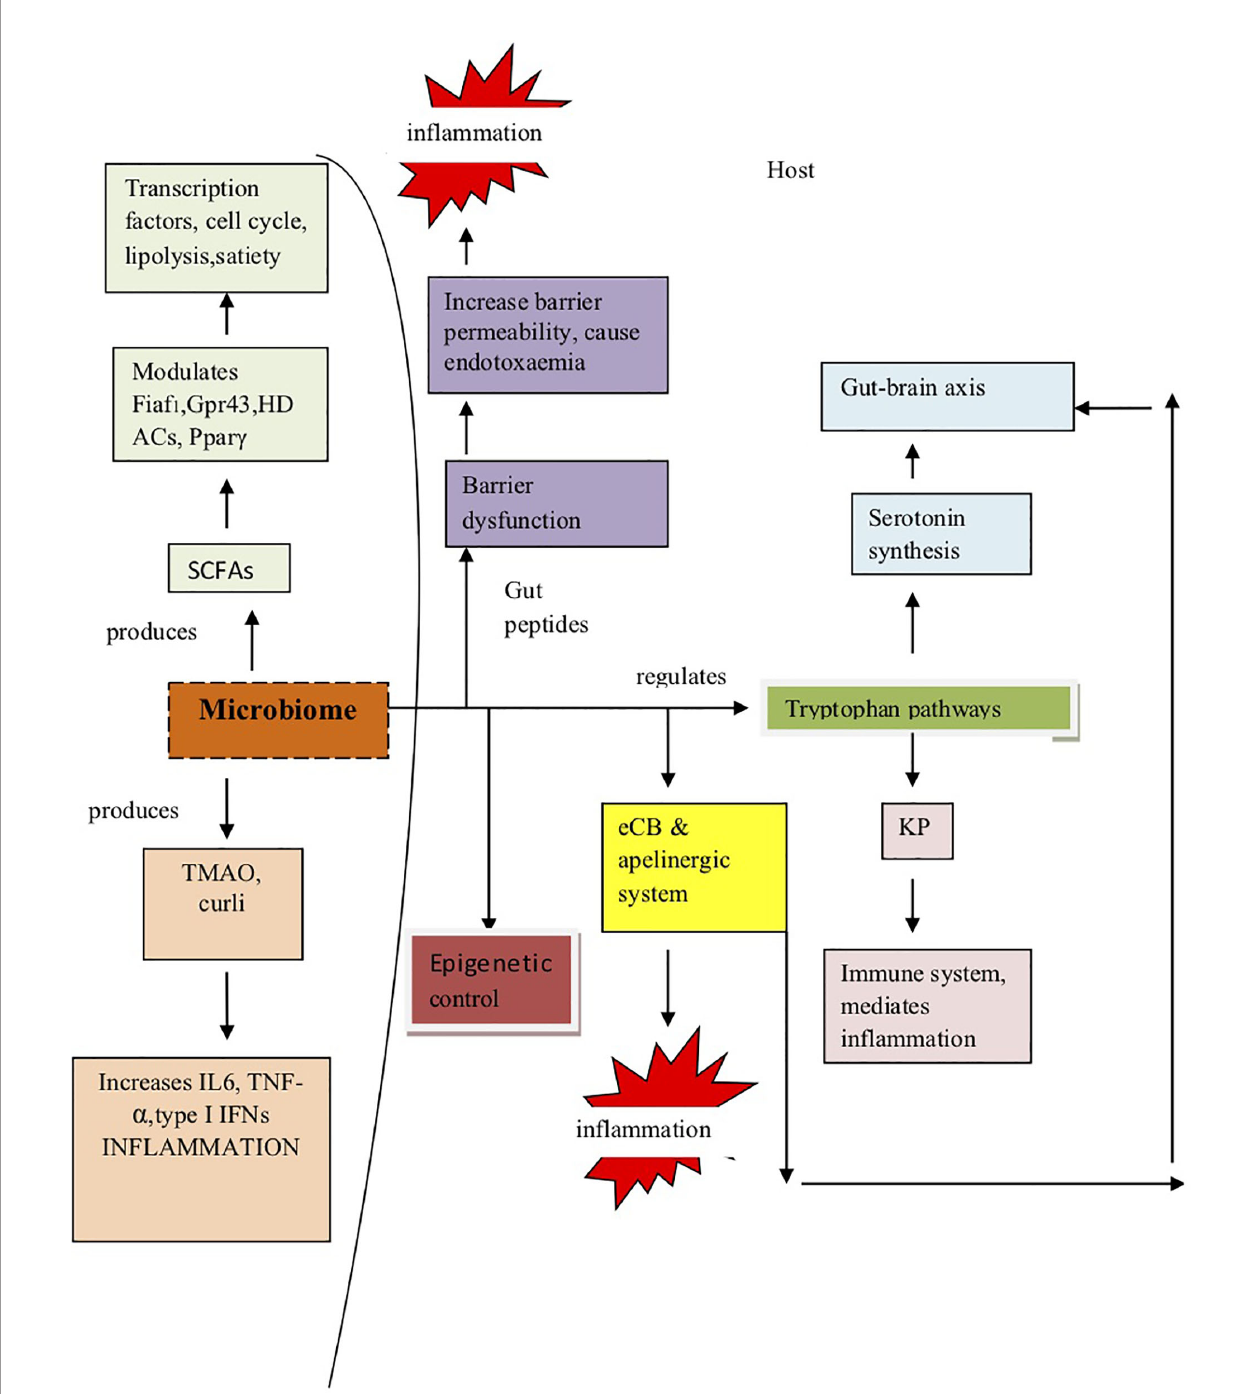
FIGURE 2 | The fi gure shows the different mechanisms by which the microbiome has been found to regulate in fl ammation. The diagram shows that the microbiome undergoes dysbiosis due to various factors. The abnormal microbiome causes in fl ammation via different pathways, which may include the kynurenine pathway (KP), the endocannabinoid system (eCB), barrier dysfunction (via gut peptides), and regulation of synthesis of different host metabolites like serotonin (5-hydroxytryptamine, 5-HT). Both serotonin and kynurenine are products of tryptophan catabolism. Serotonin is a crucial neurotransmitter helping in the communication across the gut – brain axis. Apart from this, the microbiome itself produces a host of metabolites like SCFAs, TMAO, and curli, which modulates the immune system and other cellular and metabolic processes leading to outcomes like in fl ammation and perturbation of homeostasis. These conclusions are based on evidence gathered from other disorders. These pathways are hypothesized to signi fi cantly contribute to the pathogenesis of COVID-19, which is characterized by severe in fl ammation and tissue injury.